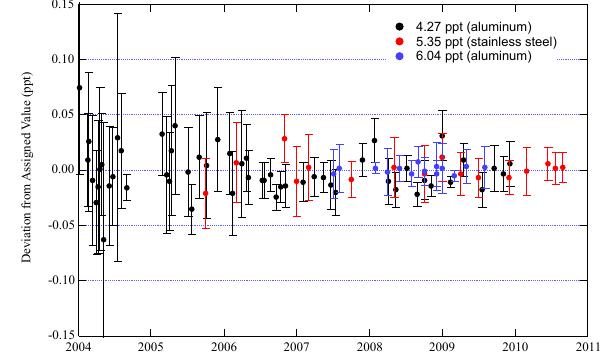
-0.15-0.10-0.050.000.050.100.15 Fig. 5. Reproducibility of SF 6 calibration assignments. Since 2006 Figure 5: Reproducibility of SF 6 calibration assignments. Since 2006 the mean deviation has 542 the mean deviation has been − 0.005ppt, 0.002, and 0.005ppt for been -0.005 ppt, 0.002, and 0.005 ppt for 4.27, 5.35, and 6.04 ppt target standards, respectively. 543 4.27, 5.35, and 6.04ppt target standards,